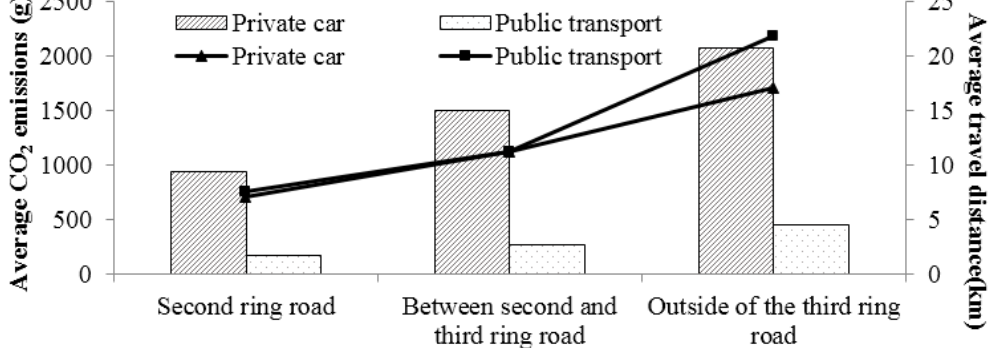
Figure 5. Average CO 2 emissions and distance traveled from different modes of